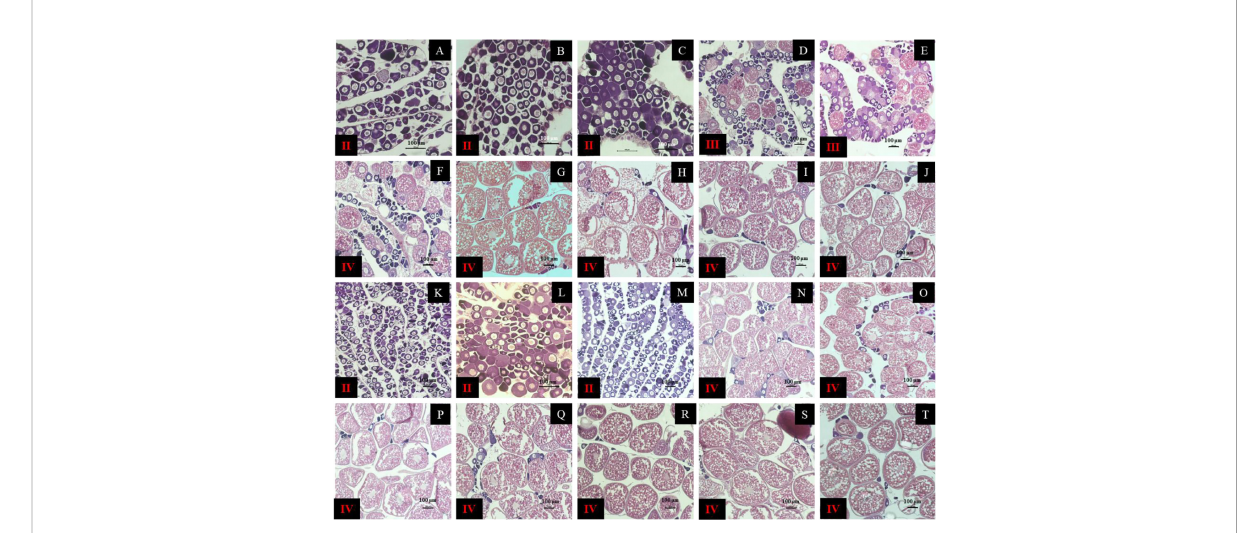
FIGURE 1 Paraf fi n section of the adult spotted scat ovary. (A – J) , SO group. (K – T) , FO group. The ovaries were at phase II, III or IV. Scale = 100